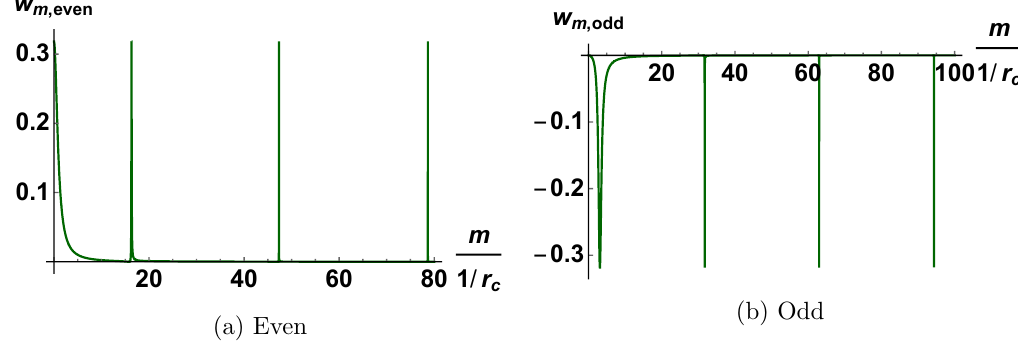
Figure 4. Wave pro(cid:12)les, with m in units of 1 =r c and R=r c = 0 :